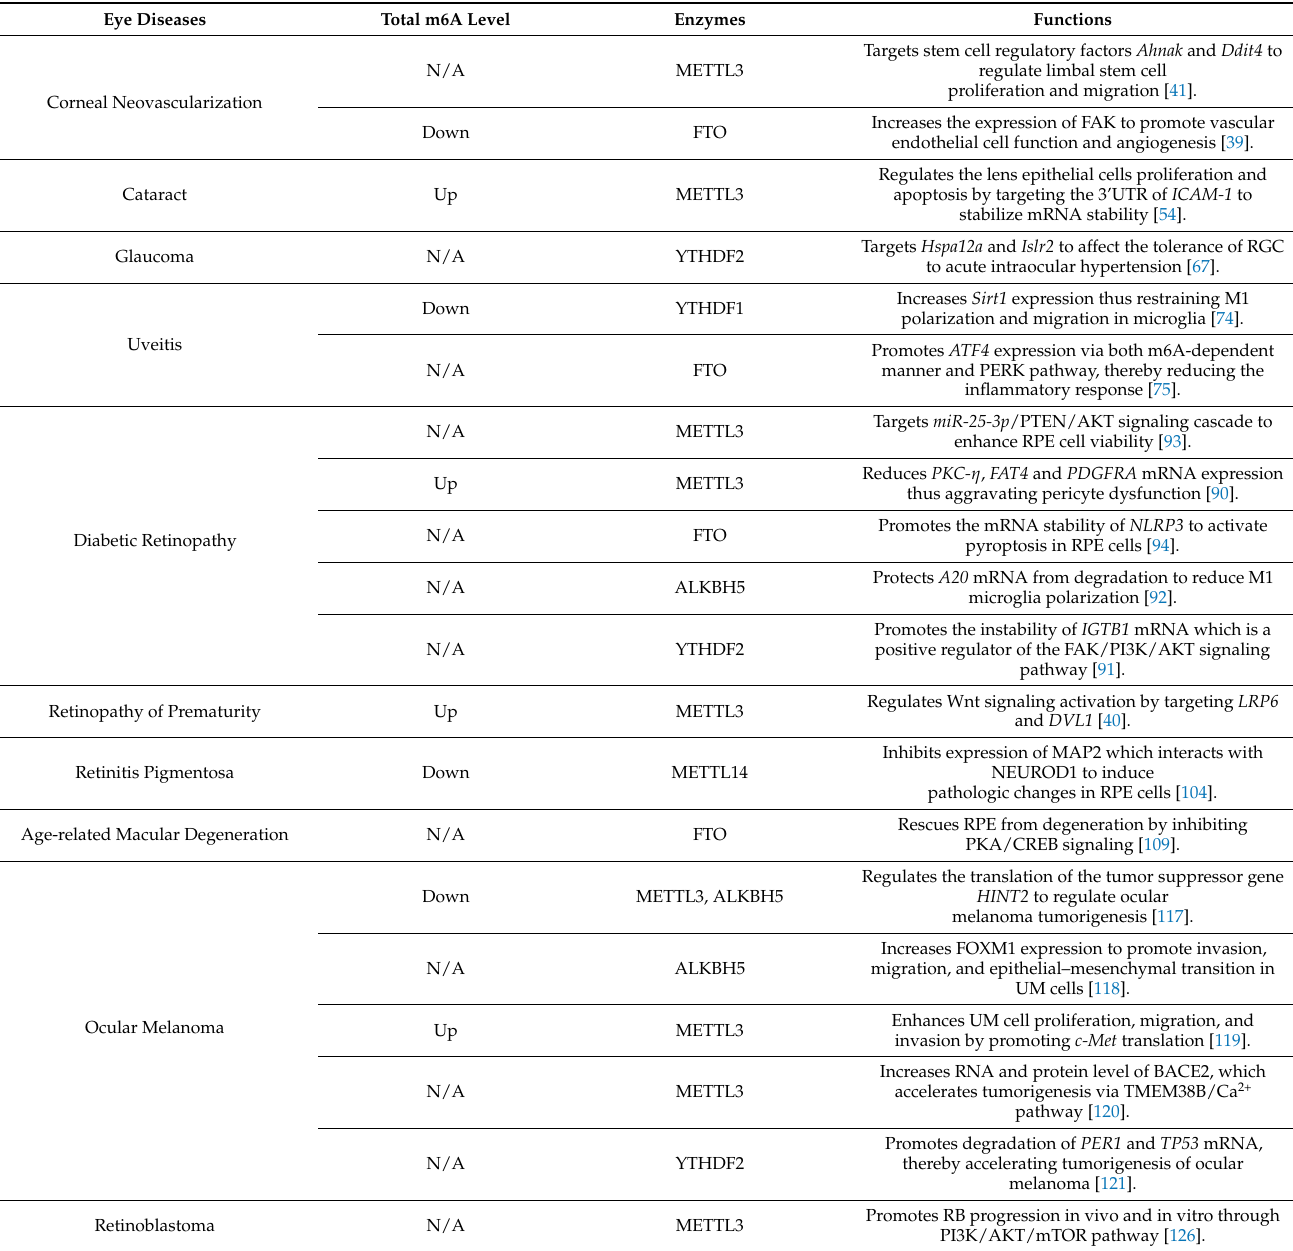
Table 1. The functions of m6A regulatory enzymes in oxidative stress-related eye